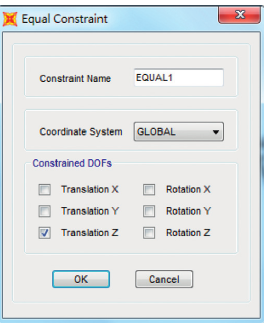
Figure 8: Equal constraints for modeling the horizontal sliding bearings.